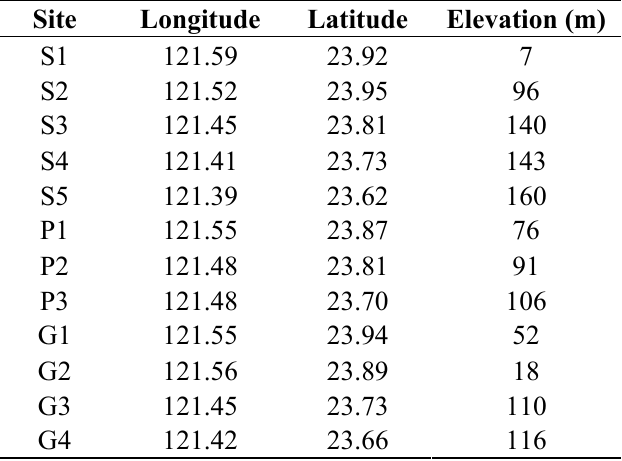
Table 1. Sampling locations of the study